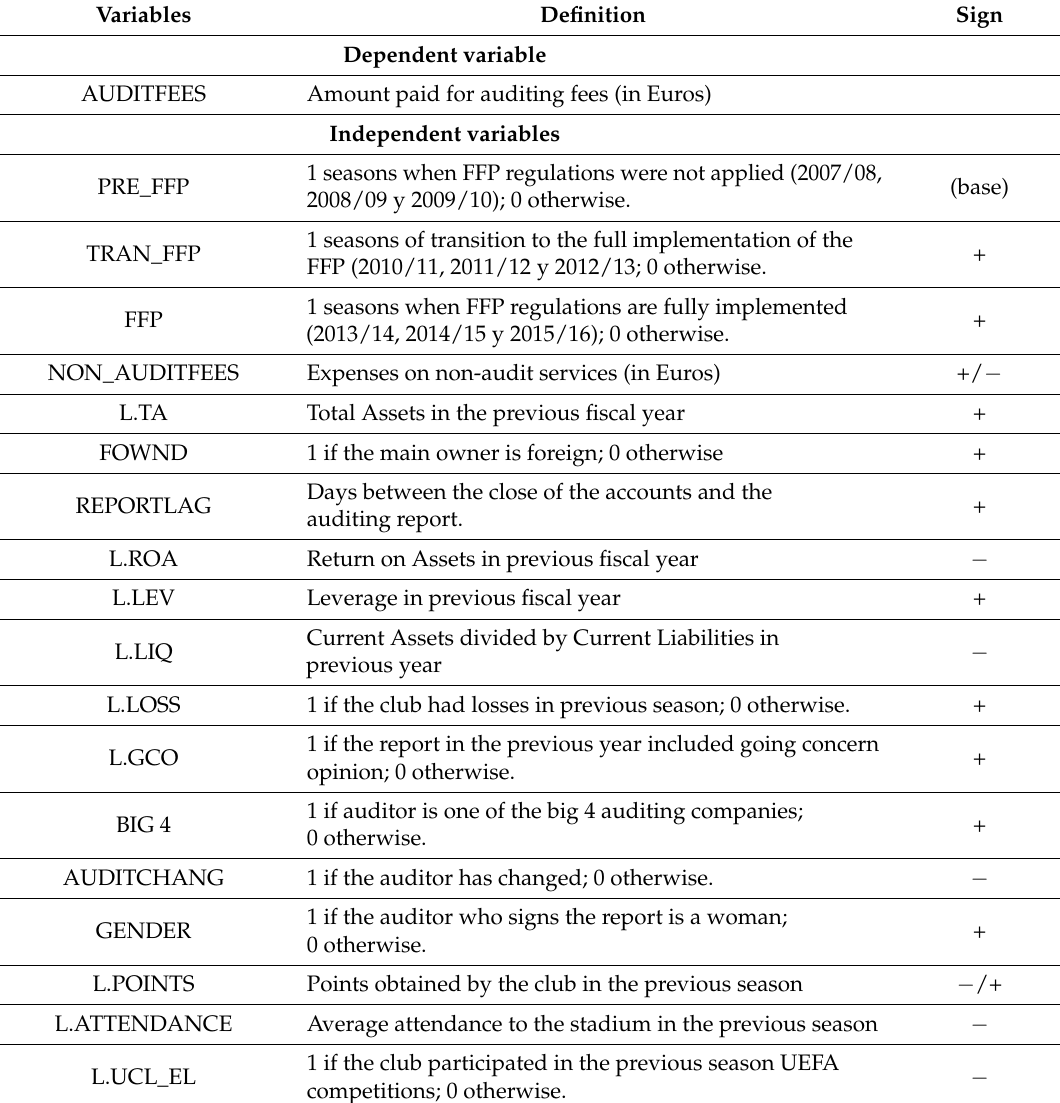
Table 5. Description of the variables included in the model and expected sign (financial variables in real